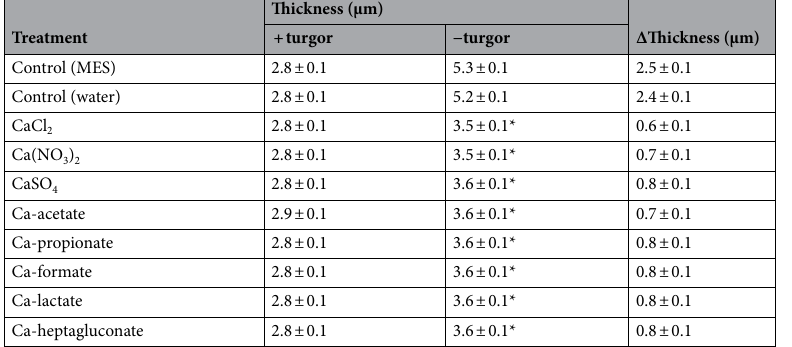
Table 2. Effects of selected anions of Ca salts on thickness and swelling (Δthickness) of anticlinal epidermal cell walls of excised skin segments (ES) of ‘Sam’ sweet cherry fruit before (+ turgor) and after turgor release (−turgor) by a freeze/thaw cycle. The ES were incubated in salt solutions at concentrations of 10 mM and buffered with 10 mM MES. The pH was adjusted to pH 5.8 using KOH or HCl. Buffer only (10 mM MES, pH 5.8) and deionized water served as controls. ΔThickness was calculated as the difference between the thickness measured after turgor release minus that measured before turgor release. Data are means ± SE. *Mean separation within columns against the MES control indicated by *, Dunnett test at p < 0.05.